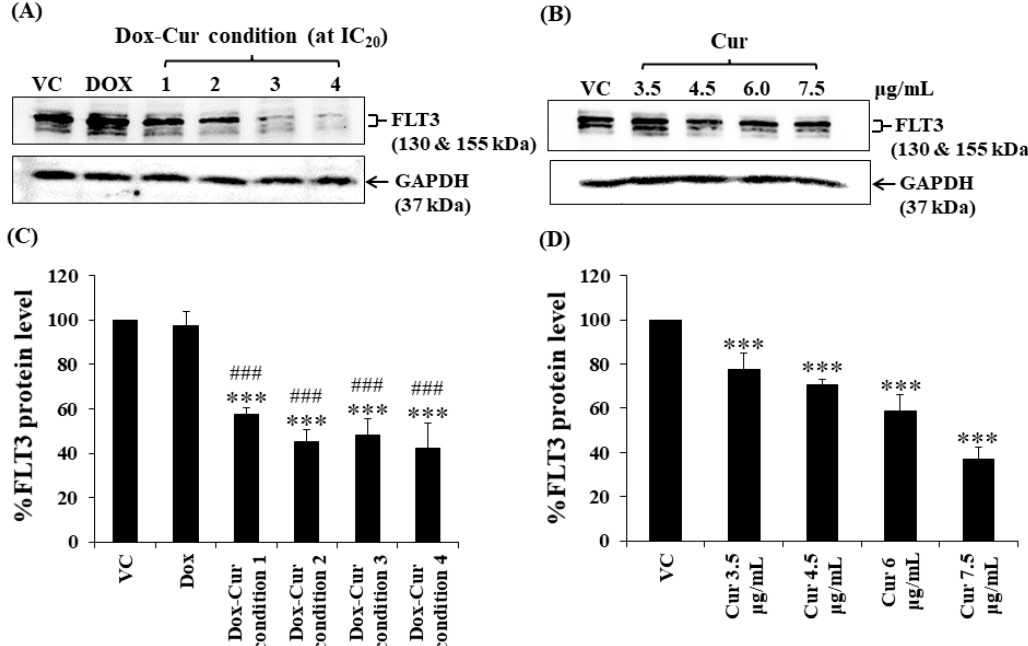
Figure 3. FLT3 protein levels of KG-1 cells after treatment with Dox and Dox–Cur at concentration value of IC 20 for 48 h. Protein bands ( A ) and percentage ( C ) of FLT3 protein levels of KG-1 cells were from DMSO (VC), Dox (58 ng/mL), Dox– Cur condition 1 (22 ng/mL Dox + 3.5 μ g/mL Cur), condition 2 (10 ng/mL Dox + 4.5 μ g/mL Cur), condition 3 (7 ng/mL Dox + 6 μ g/mL Cur), and condition 4 (6 ng/mL Dox + 7.5 μ g/mL Cur). Protein bands ( B ) and percentage ( D ) of FLT3 protein level of KG-1 cells were from DMSO (VC), Cur (3.5 μ g/mL), Cur (4.5 μ g/mL), Cur (6 μ g/mL), and Cur (7.5 μ g/mL) for 48 h. Whole protein lysates (80 μ g/lane) were loaded onto SDS-PAGE. The data are shown as mean ± SD from 3 independent experiments. The significance of mean differences was assessed using one-way ANOVA. *** p < 0.001 compared with VC. ### p < 0.001 compared with single-Dox treatment.